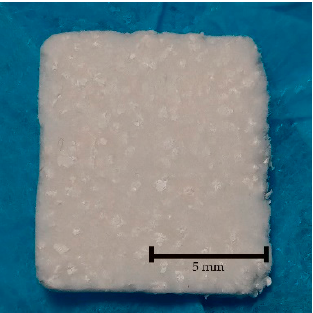
Figure 1. Porcine type I collagen mixed with porcine bone graft at a weight ratio of 30:70. Particles can be seen evenly distributed through the collagen.